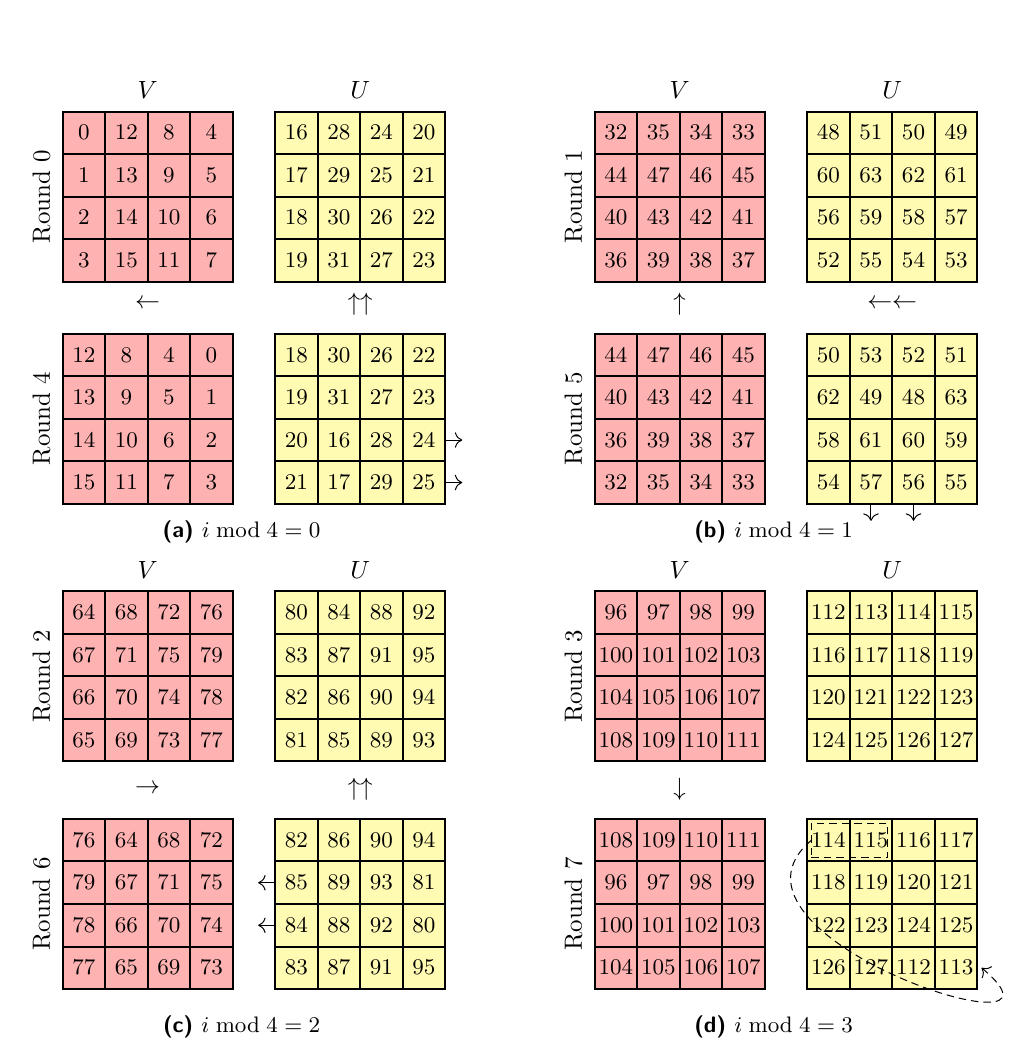
Figure 8: GIFT-64 key update functions from round i to i + 4, according to the different fixsliced representations over 4 rounds. Each cell represents a bit, and the numbers in the cells then denote the actual index of that particular bit in the 16-bit key word. Note that i mod 4 = 3 refers to the classical representation. The cell colors match the corresponding slice for the add round key